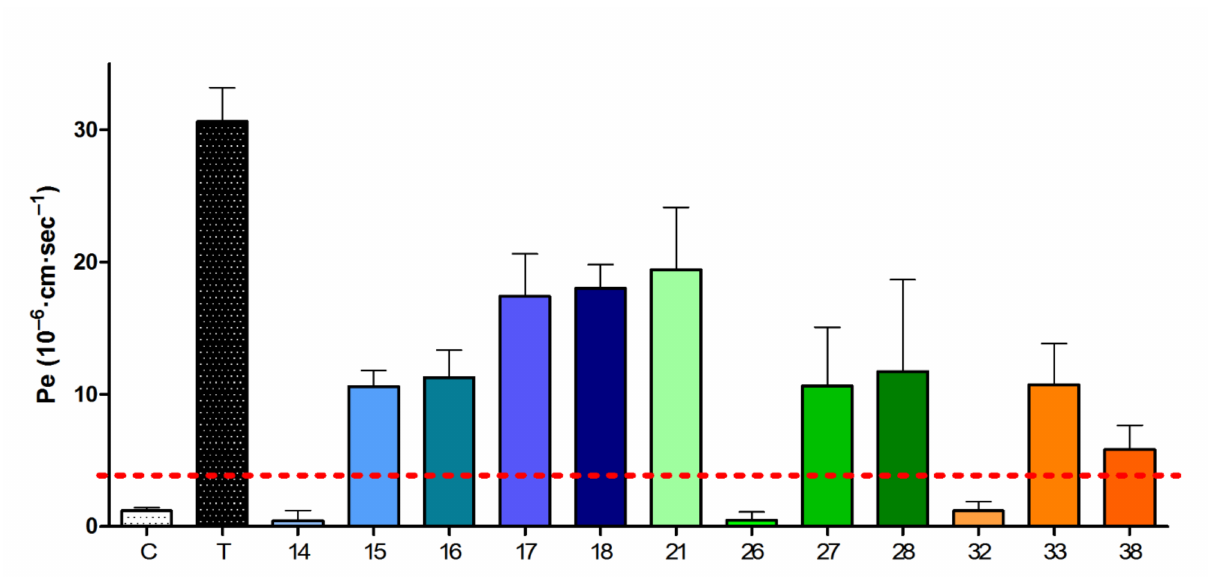
Figure 6. Blood–brain barrier (BBB) permeability evaluated by the parallel artificial membrane permeation assay (PAMPA) method. Permeability is represented as means ± SEM of three independent experiments by triplicate. C (caffeine) and T (testosterone) are negative and positive control, respectively. A value of Pe ≥ 4 indicates ability to cross the BBB